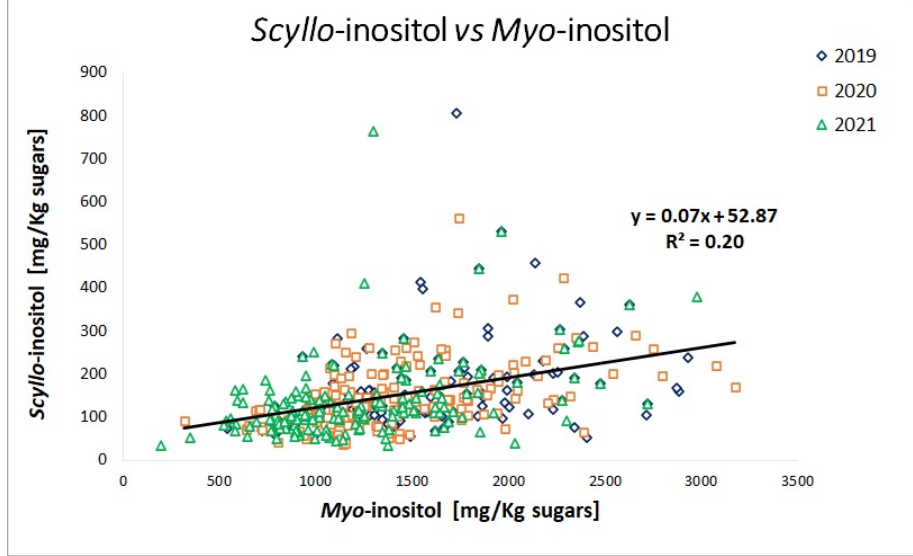
Figure 3. Linear correlation graph of scyllo -inositol with myo -inositol in grape musts. Blue ( ◊ ), red ( □ ), and green ( Δ ) points correspond to the harvest seasons in 2019 ( n = 140), 2020 ( n = 160), and 2021 ( n = 150), respectively.